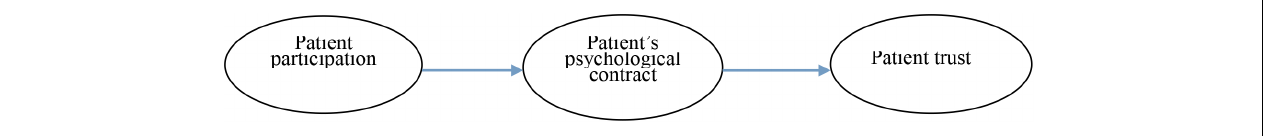
FIGURE 1 | Conceptual model of this study.